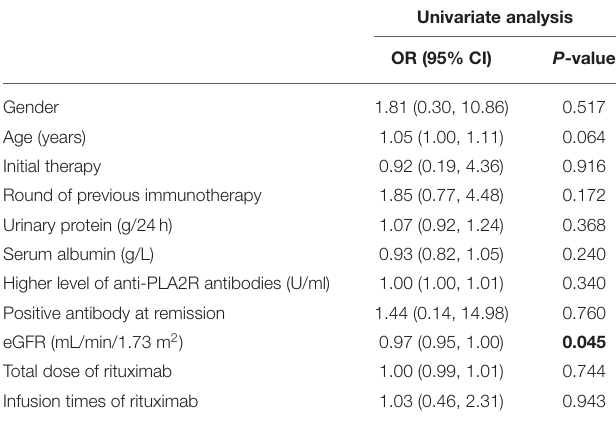
TABLE 4 | The risk factors for relapse of patients with pMN receiving rituximab. TABLE 5 | The risk factors for kidney dysfunction of patients with pMN receiving rituximab as eGFR decreased > 50% or ESRD (Cox